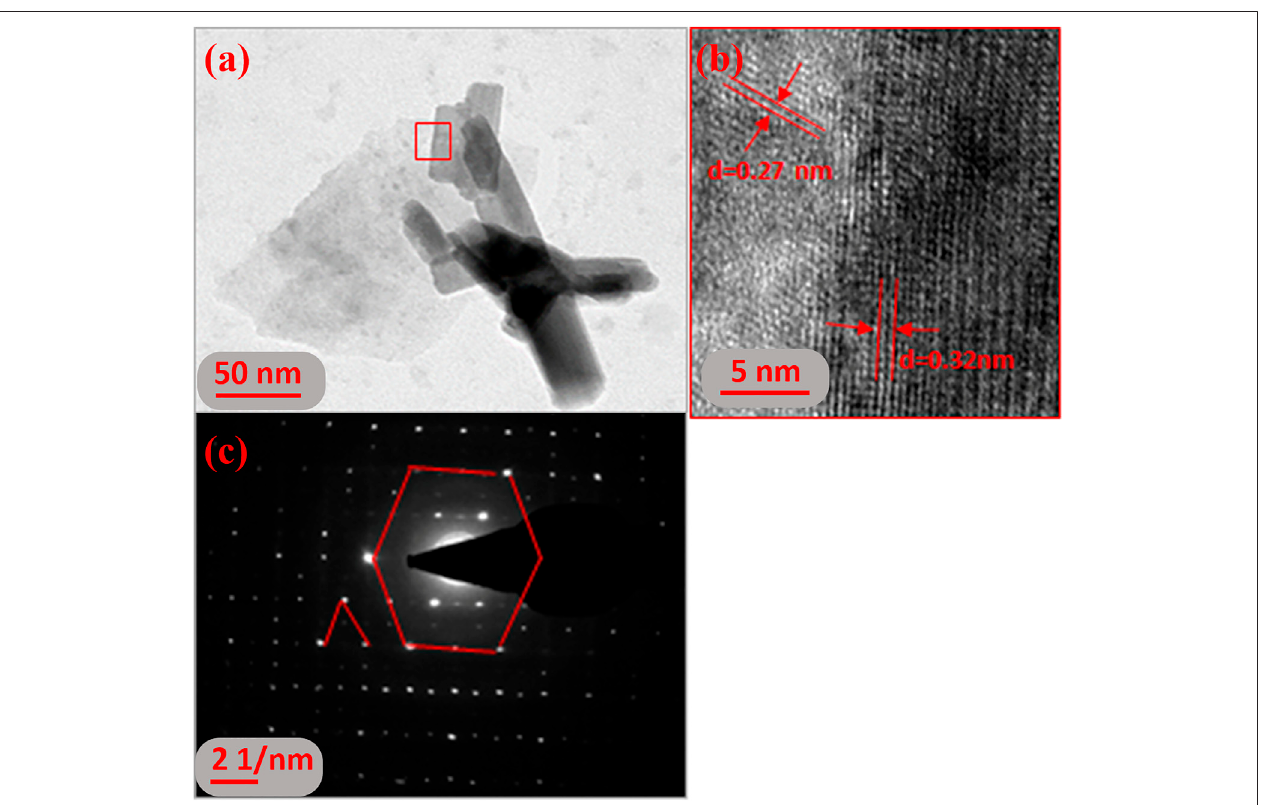
FIGURE 4 | (A) TEM, (B) HRTEM, and (C) SAED pattern images of 15% Cs x WO 3 /MoS 2 nanocomposite.